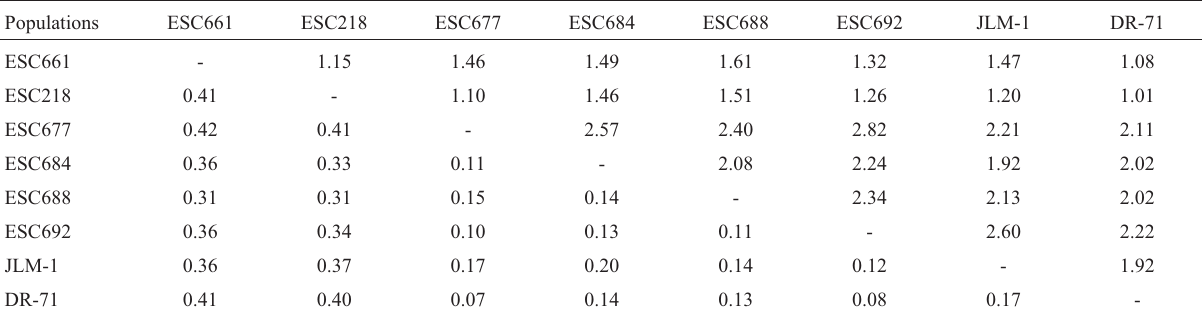
Table 5 - Pairwise (cid:3) ST (below diagonal) and gene flow ( N m , above diagonal) indices estimated for populations of Calydorea crocoides . Populations